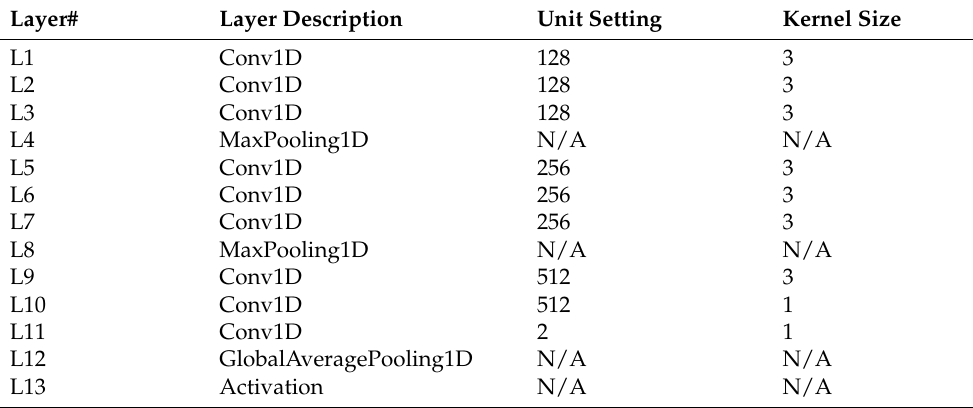
Table 8. Model 4—The proposed CNN